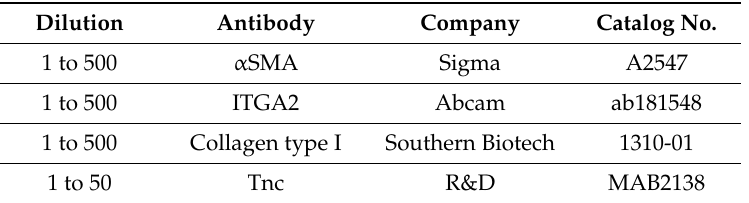
Table 4. Primary antibodies used for Immunofluorescence